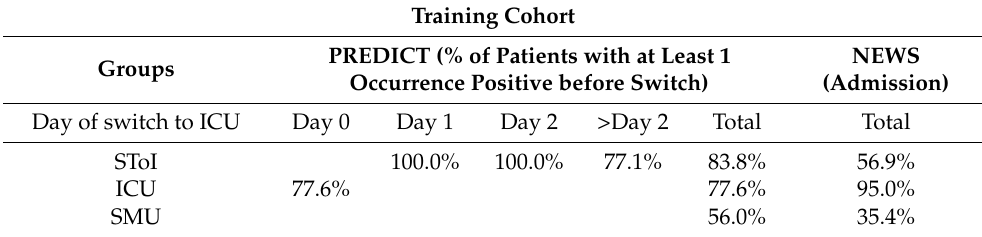
Table 10. Percentages of patients that have at least one positive occurrence for PREDICT score before their switch day (calculated at day 0 for ICU group, day 0 and day 1 for patients who switch after 1 day of hospitalization in SToI group, day 0 and day 1 and day 2 for patients who switch after at least 2 days of hospitalization in SToI group). Line SMU represent the percentage of patient with a positive score at least one time (day 0 and day 1 and day 2) in SMU group.